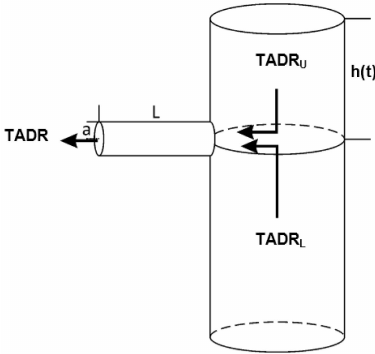
Figure 10. Geometry of the model for the eruptive flux from an ephemeral vent at Stromboli volcano. The model has been taken from Ripepe et al. [8].